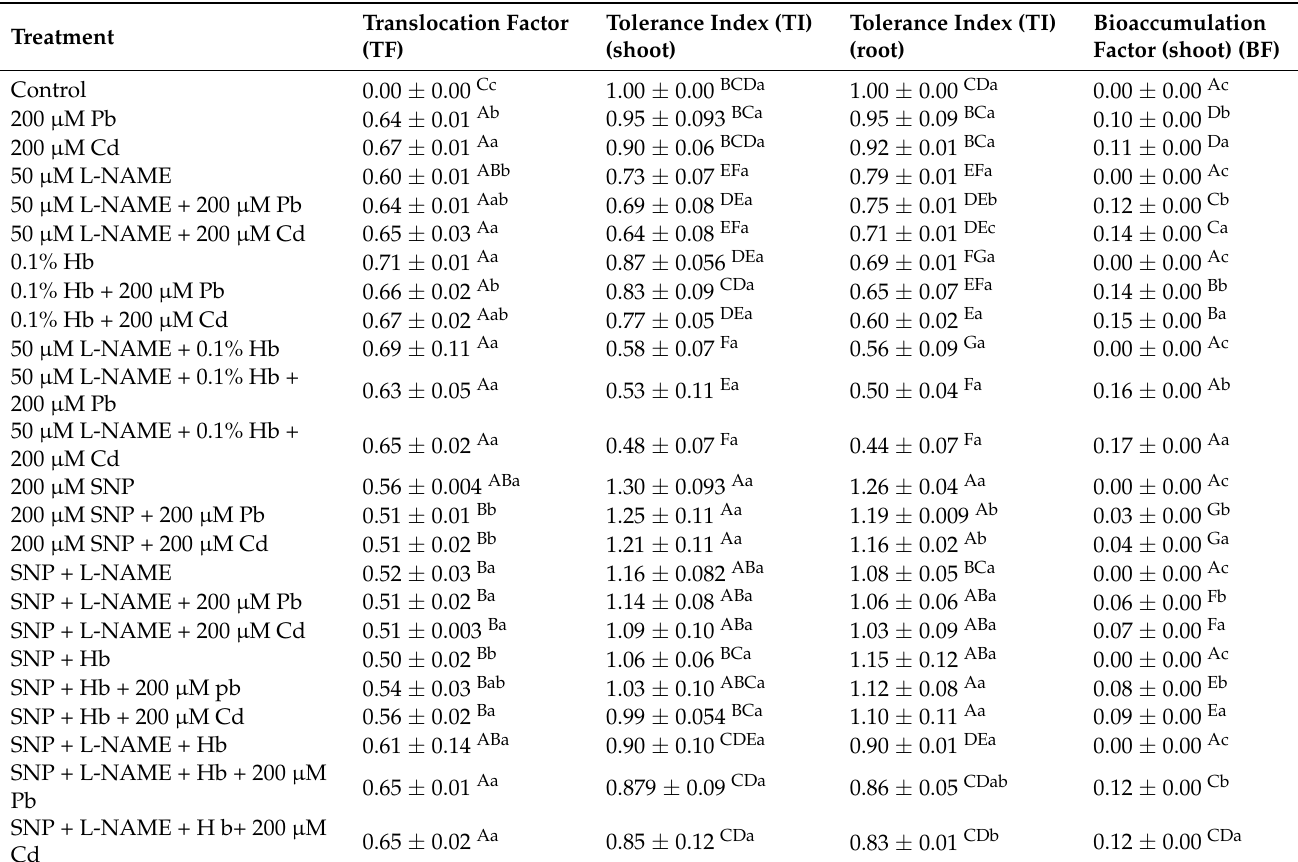
Table 5. The impact of various levels of nitric oxide on translocation factor (TF), bioaccumulation factor (BF) (shoot), and tolerance index (TI) of shoot and root in bamboo species under heavy metals toxicity (200 µ M Pb and 200 µ M Cd).